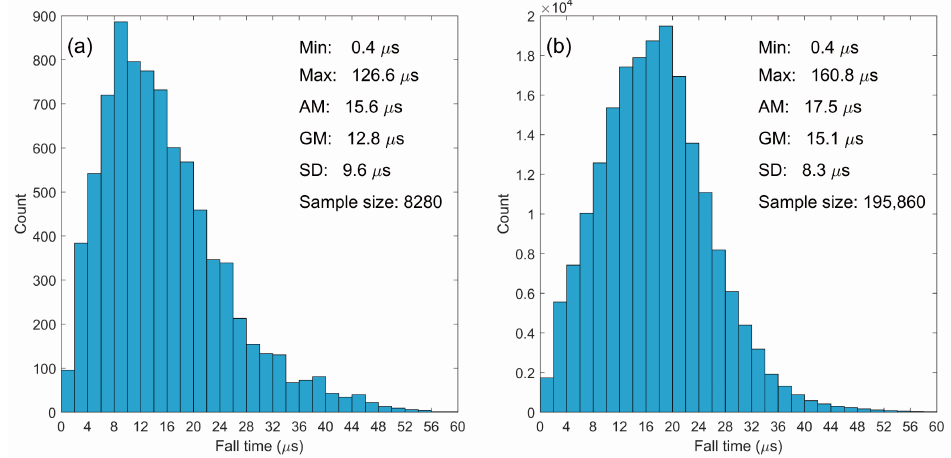
Figure 7. Histograms of fall time for RS pulses: ( a ) positive RS; ( b ) negative RS; Here, Min, Max, AM, GM, and SD are abbreviations for Minimum, Maximum, Arithmetic mean, Geometric mean, and Standard deviation, respectively. Table 3. Comparison of fall time among different studies.